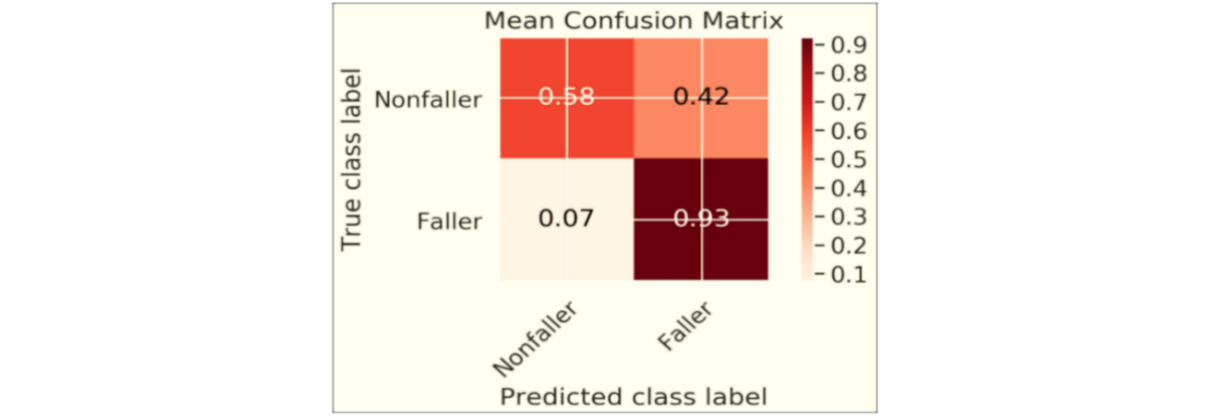
Figure 2. Confusion matrix averaged over all five models.